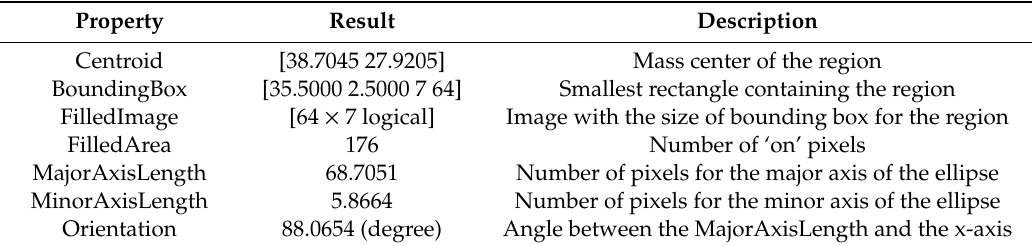
Table 4. Properties of the image region, results, and descriptions.